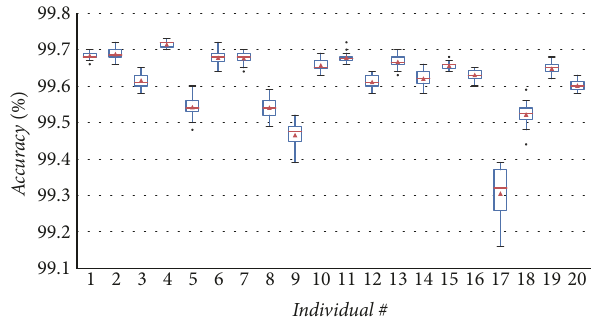
Figure 6: Boxplot showing the distribution of accuraciesof the best 20 GE individuals after full training in the EMNIST Digits dataset.